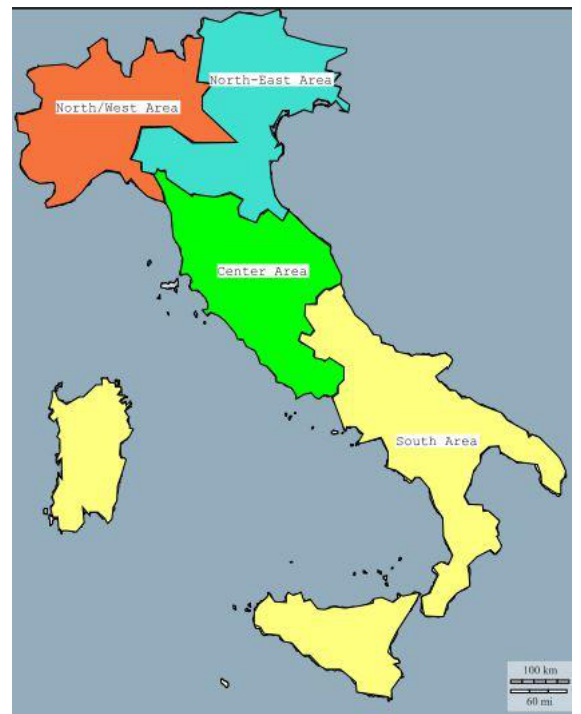
Figure 1 Geographical Macroarea Figure 1. Geographical